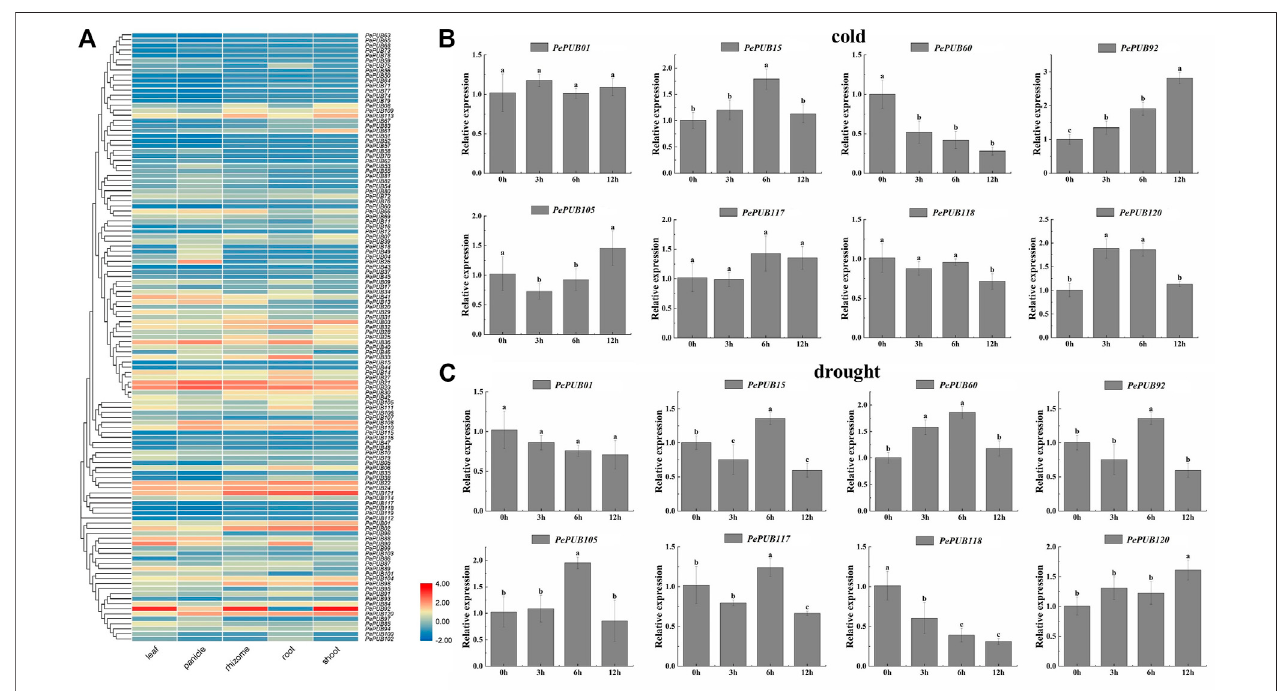
FIGURE 4 | (A) Tissue-speci fi c gene expression patterns of 121 PePUB genes. The expression patterns of 121 PePUB genes in leaf, panicle, rhizome, root, and shoot. The color scale illustrates the log2 (TPM + 1), red and blue colors reveal the high or low transcript abundance, respectively. (B) Expression pro fi les of eight candidate PePUB genes under low temperature treatment. (C) Expression pro fi les of eight candidate PePUB genes under drought stress. The values on X axis and Y axis represent the time point (hour) and the relative gene expression levels, respectively. The error strip represents three independent standard deviations (SD). Biological repetition. Different lowercase letters showed signi fi cant differences, which were determined by one-way analysis of variance, and then Duncan ’ s multi-range test ( p < 0.05).